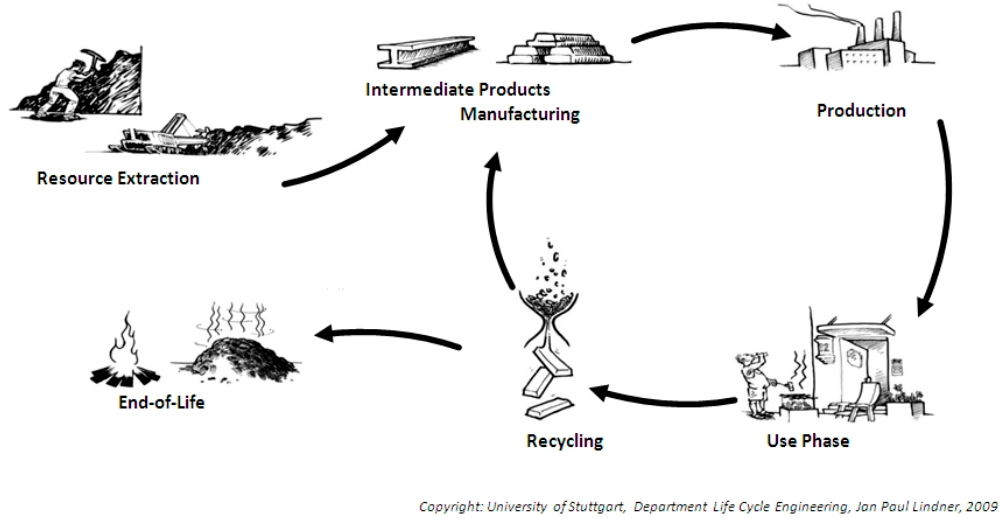
Figure 1. Schematic visualization of the life cycle of a product. Source: University of Stuttgart.